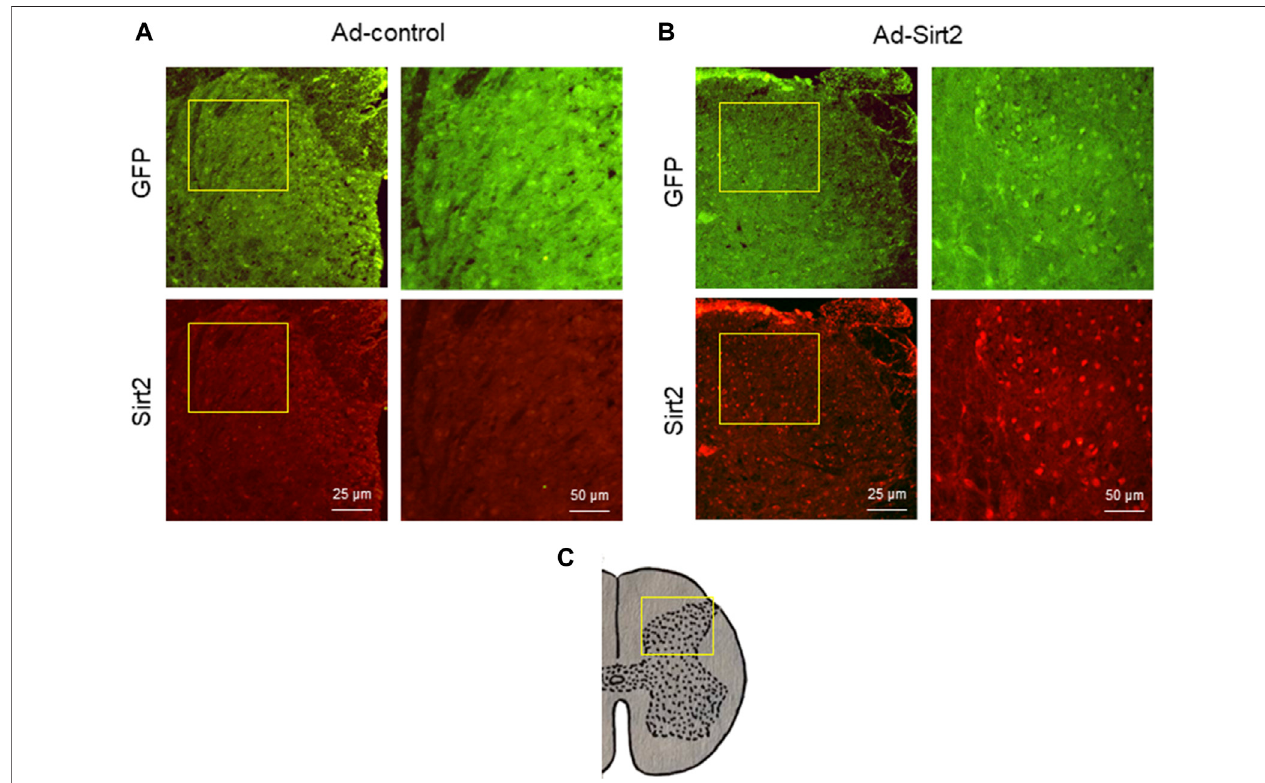
FIGURE 8 | (A,B) : Representative confocal images showing GFP (green) and Sirt2 (red) immunoreactivity in the spinal cord of SNI rats treated with Ad-Sirt2 or Ad-control. Right column of images in Ad-control group or Ad-Sirt2 group: higher-power magni fi cation of a section of the left images. (C) : Cross section of spinal cord showing where the left column of images in A and B were